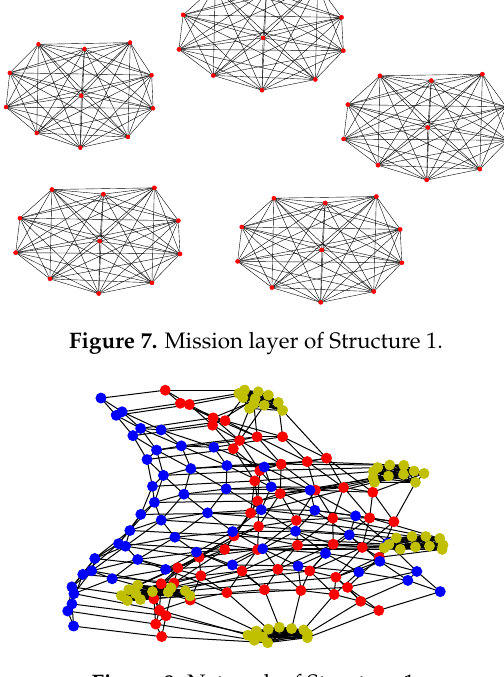
Figure 8. Network of Structure 1.